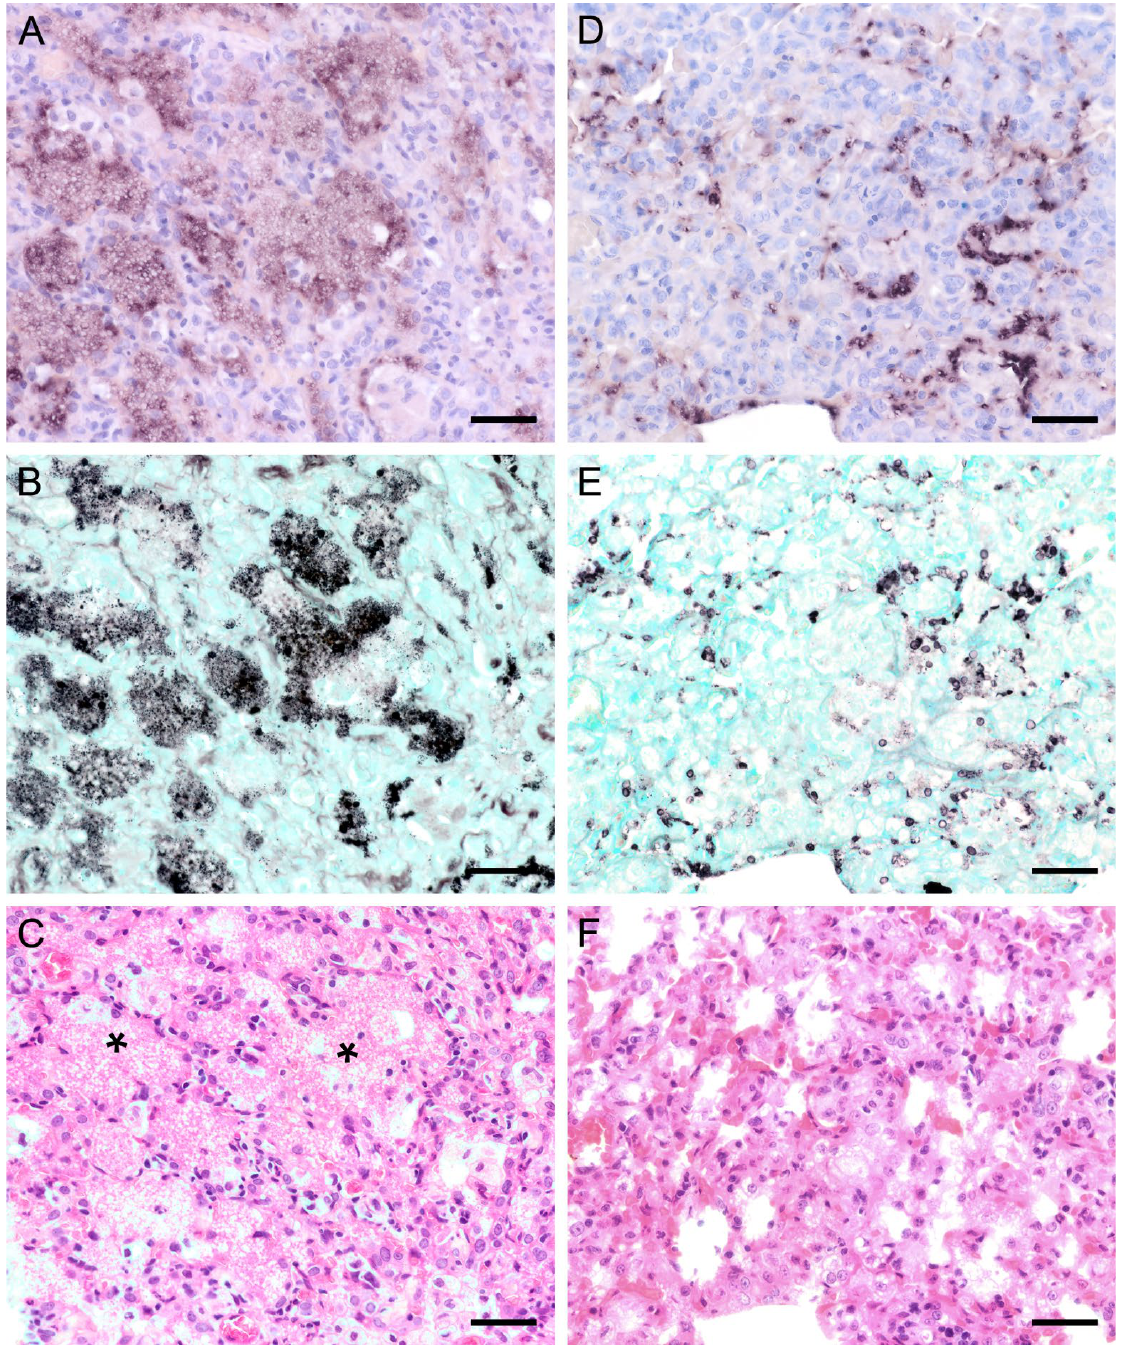
Figure 3. Adjacent sections from the same lung area of a laboratory rat with high and a pet rat with moderate loads of Pneumocystis spp. organisms are shown in comparison after ISH, GMS, and H&E staining. ( A ) ISH labels large colonies of numerous Pneumocystis developmental stages in the lung of a laboratory rat. The lung alveoli are filled with the fungus. Bar = 40 µ m; ( B ) The number of GMS-stained asci is extraordinarily high. Bar = 40 µ m; ( C ) H&E staining reveals an interstitial pneumonia with moderate alveolar histiocytosis. Pneumocystis colonies are recognizable by their ‘honeycomb’ appearance (asterisks). Bar = 40 µ m. ( D ) ISH labels Pneumocystis organisms attached to the alveolar walls of the lung of a pet rat. Bar = 40 µ m; ( E ) GMS labels exclusively cystic forms Bar = 40 µ m. ( F ) H&E staining reveals an interstitial pneumonia Bar = 40 µ